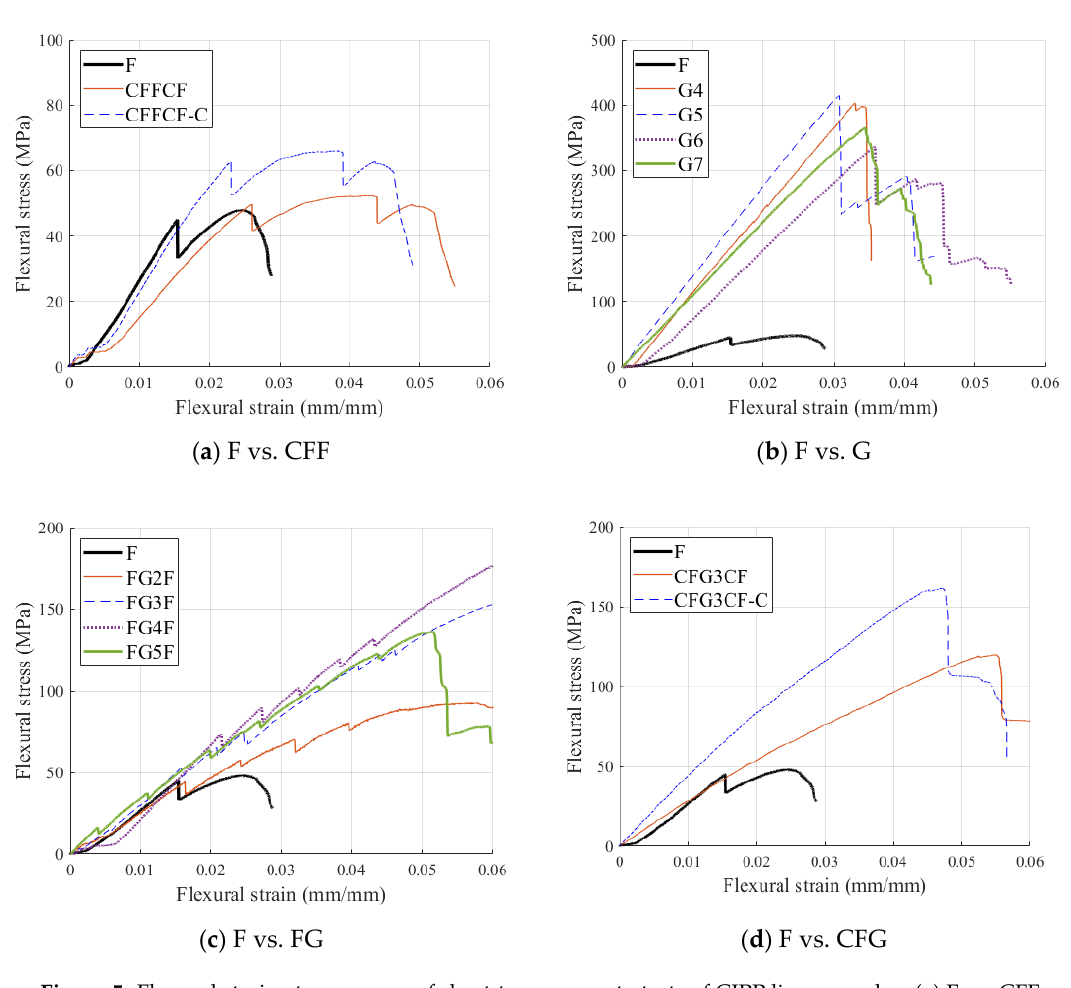
Figure 5. Flexural strain-stress curves of short-term property tests of CIPP liner samples: ( a ) F vs. CFF ( b ) F vs. G, ( c ) F vs. FG, and ( d ) F vs. CFG.